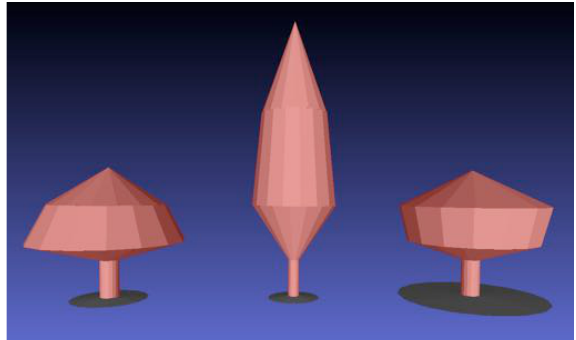
Figure 8. From Left to right, Heart-shaped root, Tap-root, and surface-root examples are presented as LOD 0, where the horizontal influence area of the root is projected on the terrain.